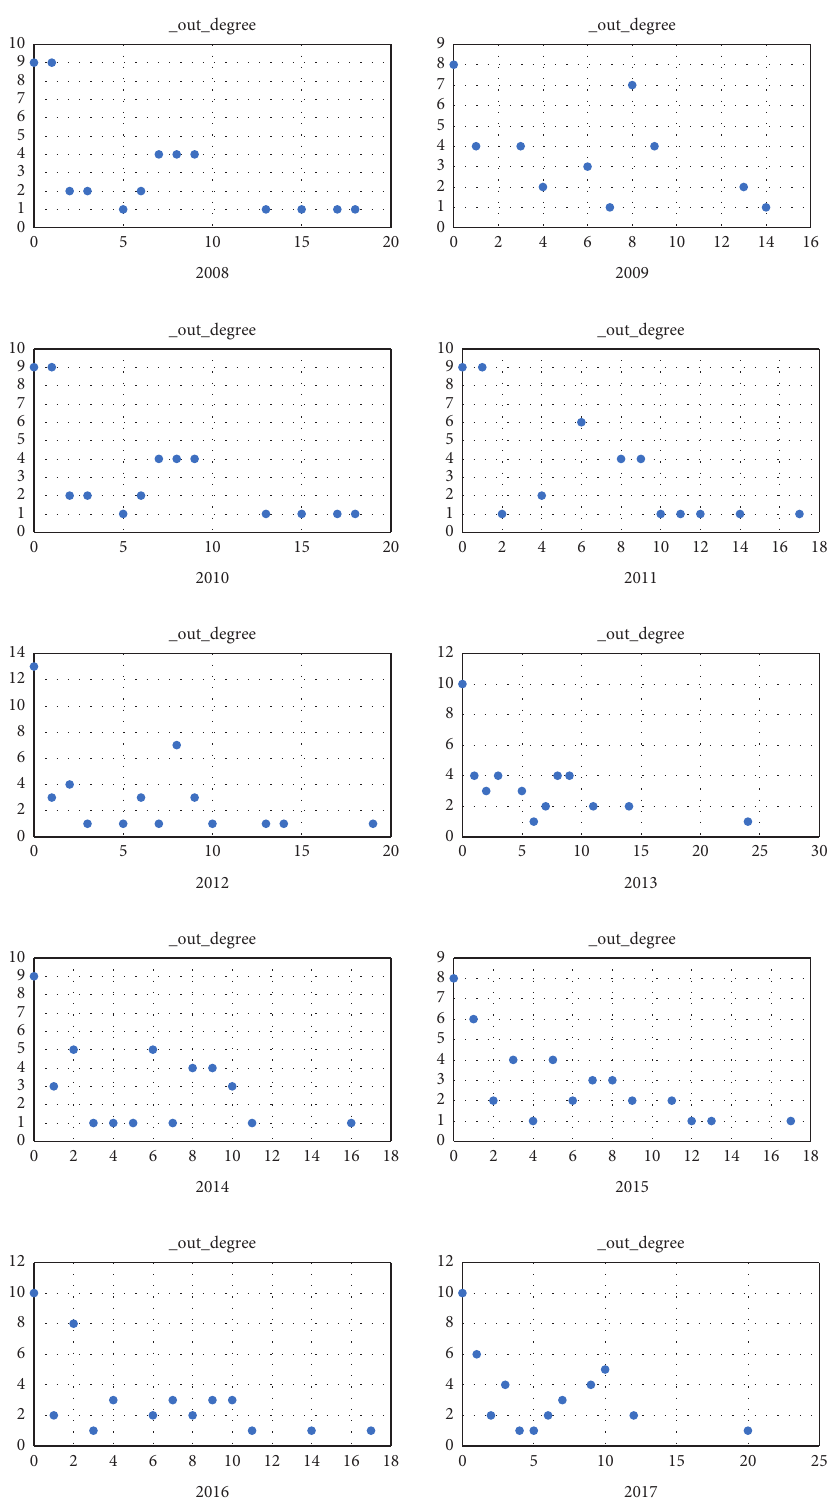
Figure 4: Out-degree indicator of the Asian crude oil market network. Source: results calculated from the software STATA